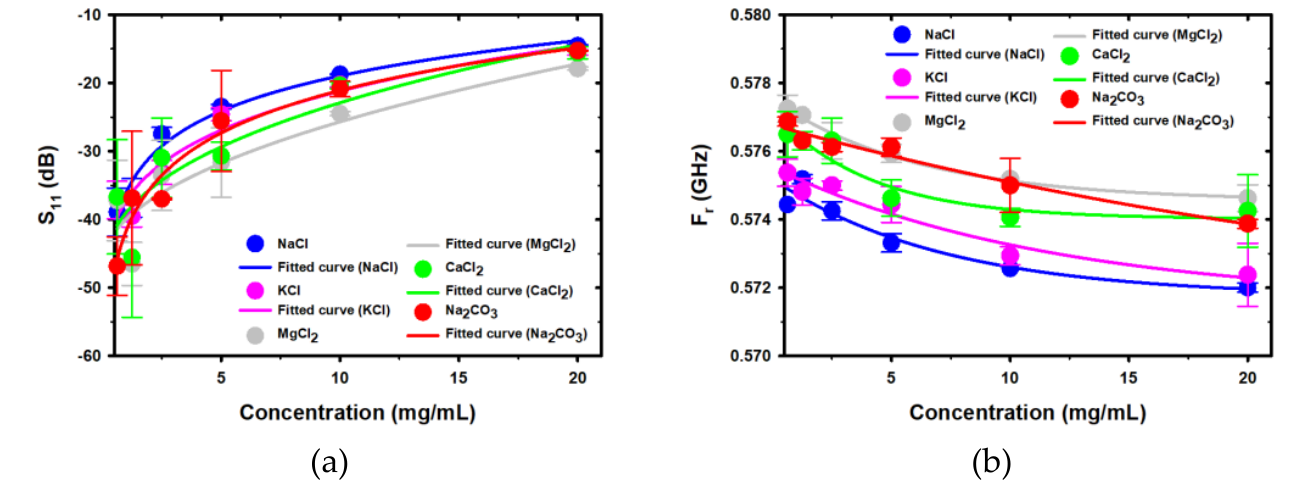
Figure 7. The relationship between the concentration of salt in water in the frequency range of the first resonance peak and the resulting values of ( a ) S 11 and ( b ) F r . The relationship between the S 11 and F r and the concentrations of salt in the range of 0.625–20 mg/mL in the second resonance peak is shown in Figure 8. Figure 8a shows the non-linear correlation between the S 11 and the concentration of salt, with the equations and parameters of this relationship for each salt provided in Table 3. The results showed that the relationship can be divided into two ranges at concentrations of 0.625–5 mg/mL and 5–20 mg/mL for NaCl, KCl, CaCl 2 , and Na 2 CO 3 , while the MgCl 2 sample is divided into two ranges between 0.625–10 mg/mL and 10–20 mg/mL. Figure 8b shows the linear correlation between the F r and the concentration of salt. The equations and parameters